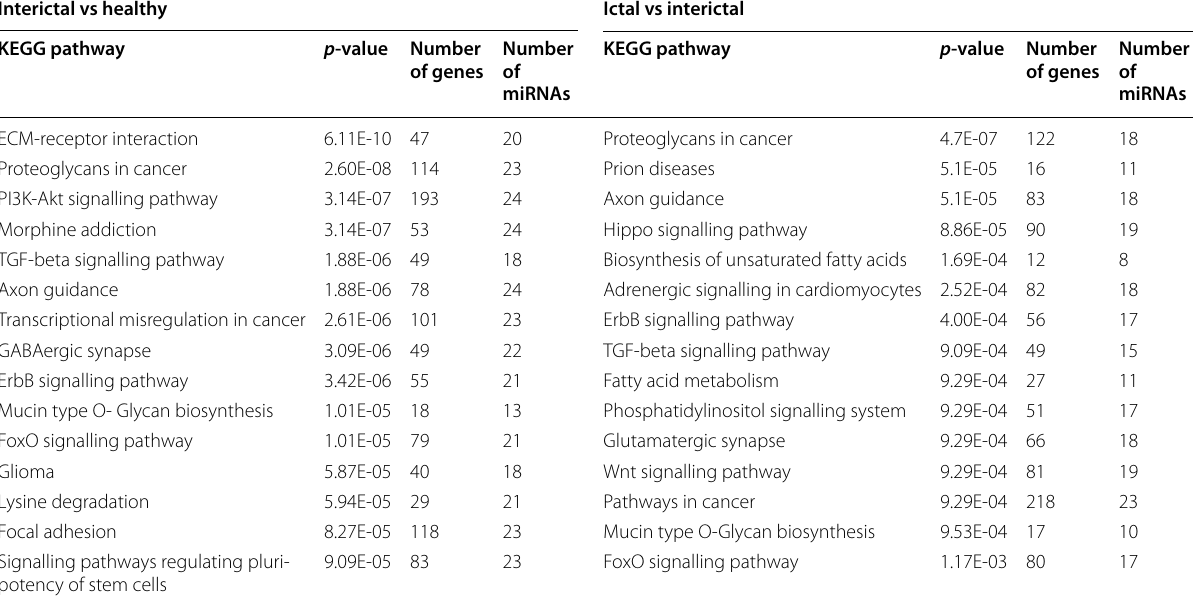
Table 4 Top 15 pathways containing the list of KEGG results from the Mirpath v3 webtool analysis Interictal vs healthy Ictal vs interictal KEGG pathway p ‑value Number